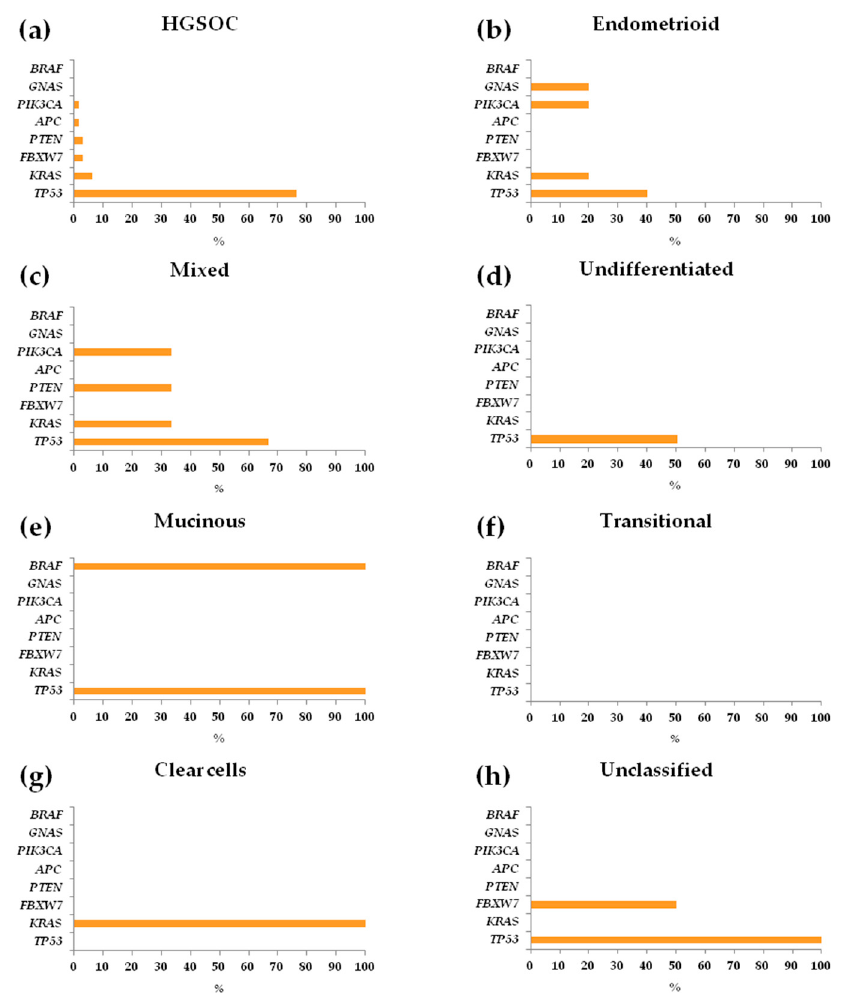
Figure 2. Mutation frequencies by ovarian cancer histological subtypes (n = 79) patients with advanced ovarian cancer. Mutation frequency was calculated as the number of variant occurrences within each gene divided for the total number of patients in the following ovarian cancer histological subtypes: ( a ) HGSOCs; ( b ) Endometrioid; ( c ) Mixed; ( d ) Undifferentiated ( e ) Mucinous; ( f ) Transitional; ( g ) Clear cells; ( h ) Unclassified. HGSOC: high-grade serous ovarian cancer. Mutations in KRAS were prevalent in mixed (1 / 3, 33.3%) and endometrioid (1 / 5, 20.0%) carcinomas, less frequent in serous samples (4 / 64, 6.2%), and an exclusive event in the clear cell tumor sample (1 / 1, 100.0%) (Figure 2a–c,g). FBXW7 mutations were identified in serous (2 / 64, 3.1%) and unclassified (1 / 2, 50%) histotypes (Figure 2a,h). PTEN mutations were identified in serous (2 / 64, 3.1%)